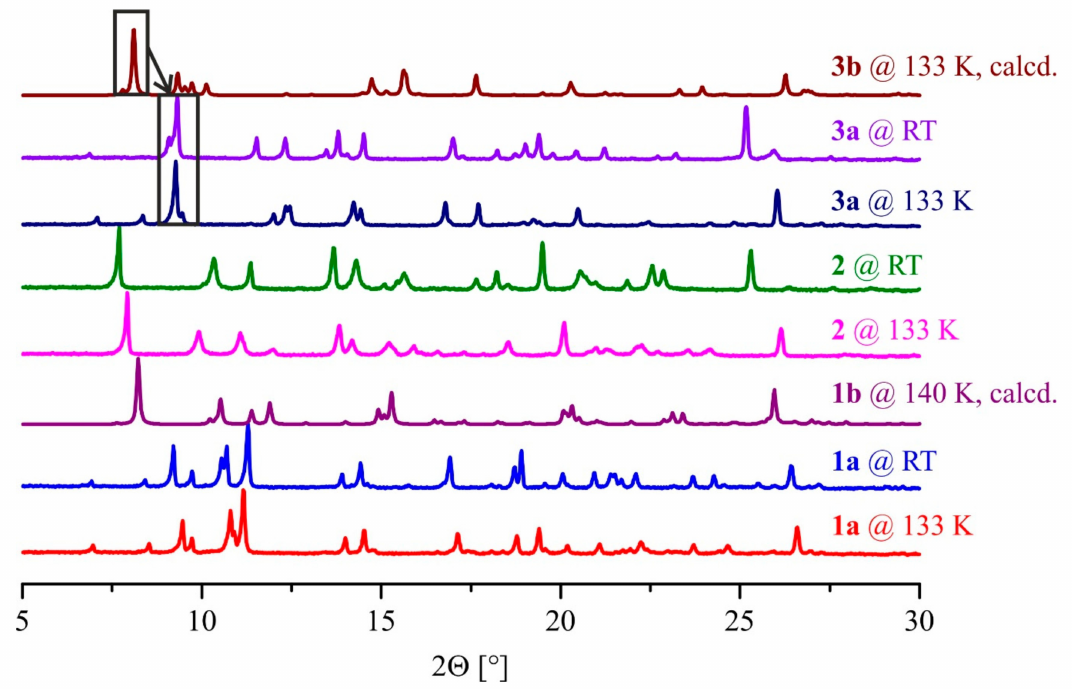
Figure 4. Powder X-ray di ff raction patterns of 1a , 1b , 2 , 3a , and 3b at the indicated